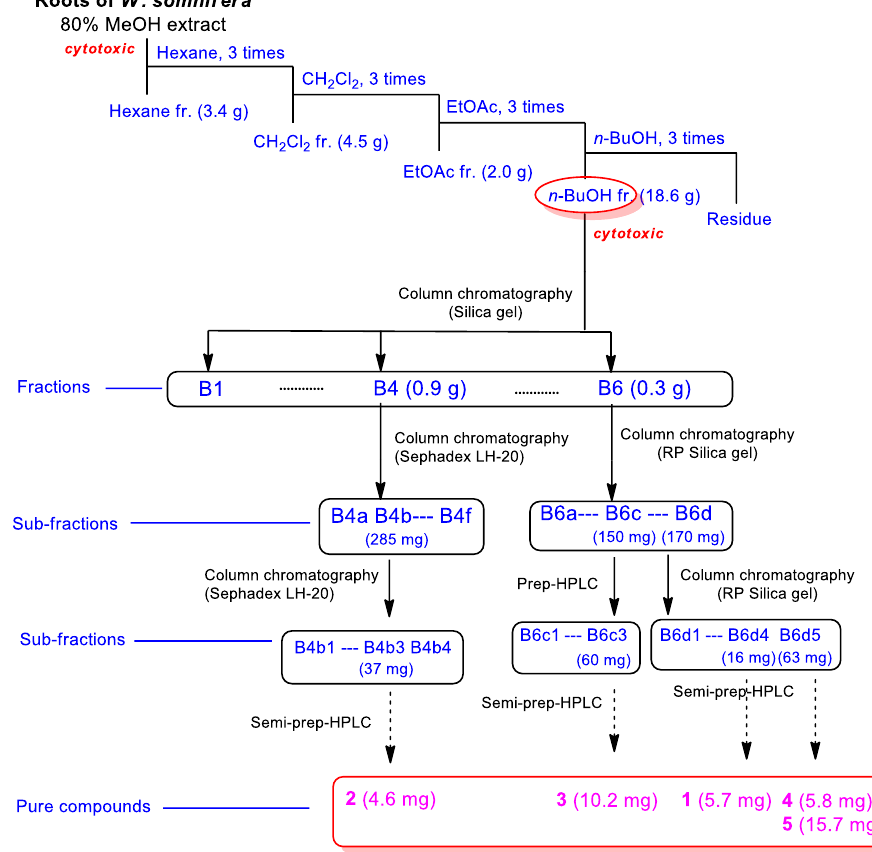
Figure 2. Bioactivity-guided isolation of compounds 1 – 5 .